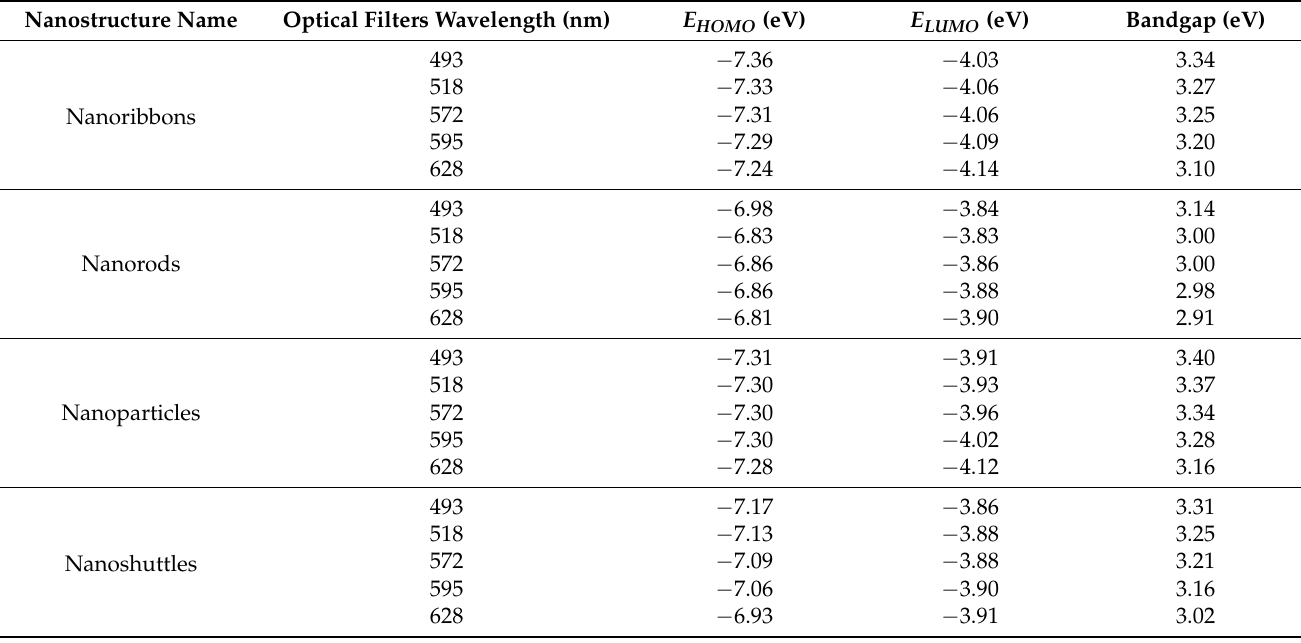
Table 2. C-V parameters of different ZnO